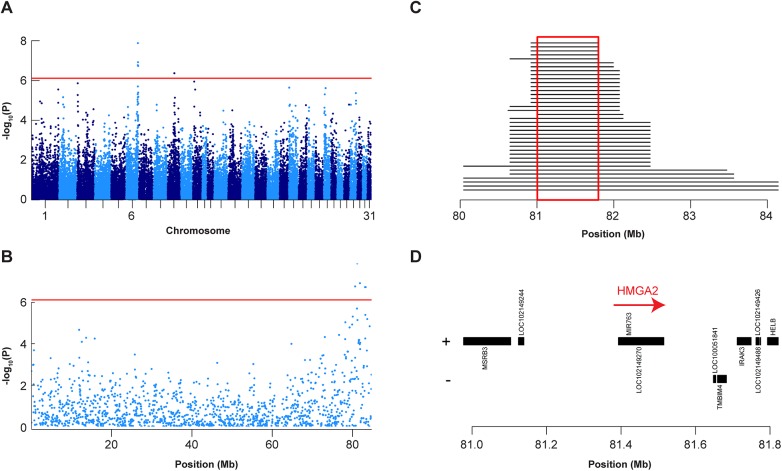
Mapping of height QTL in Shetland ponies.A: Manhattan plot of GWAS using 48 Shetland ponies and height at withers as a quantitative trait. B: Zoom of GWAS results on ECA 6. C: Haplotype analysis of the 19 smallest Shetland ponies. Each line represents one haplotype and the length of the lines represents the length of the shared haplotype block, which was defined based on a small Shetland pony that was homozygous for all significantly associated SNPs on ECA 6. D: NCBI MapViewer gene annotation in the critical interval (Annotation release 101, EquCab 2 genome assembly). The HMGA2 gene is currently not annotated in the NCBI MapViewer. Its position and orientation was determined by comparisons with the orthologous human genome segment.